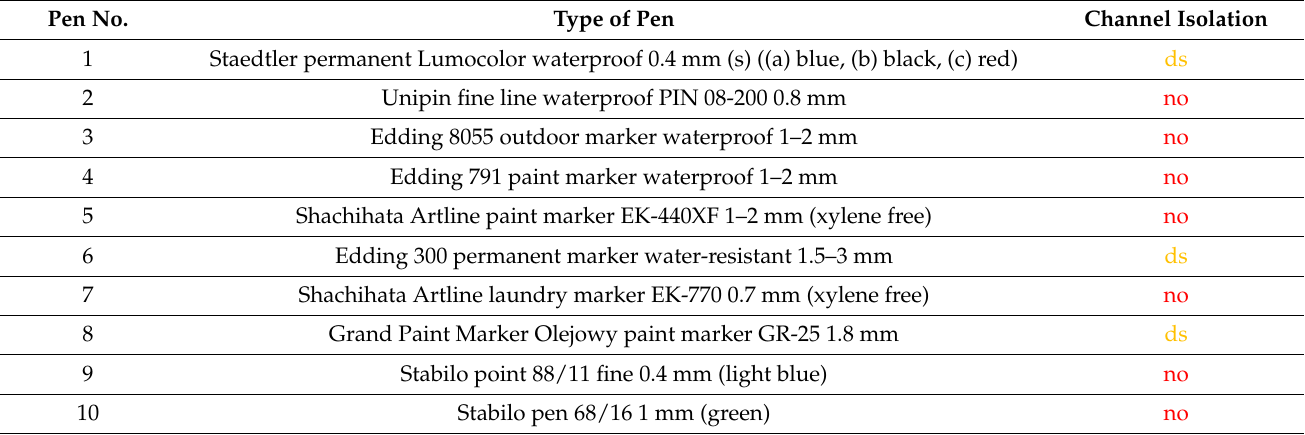
Table 2. Types of marker pens and their performance in terms of channel isolation properties (2 passes were applied to all the pens; plotting speed 2.7 cm s − 1 ). Pen